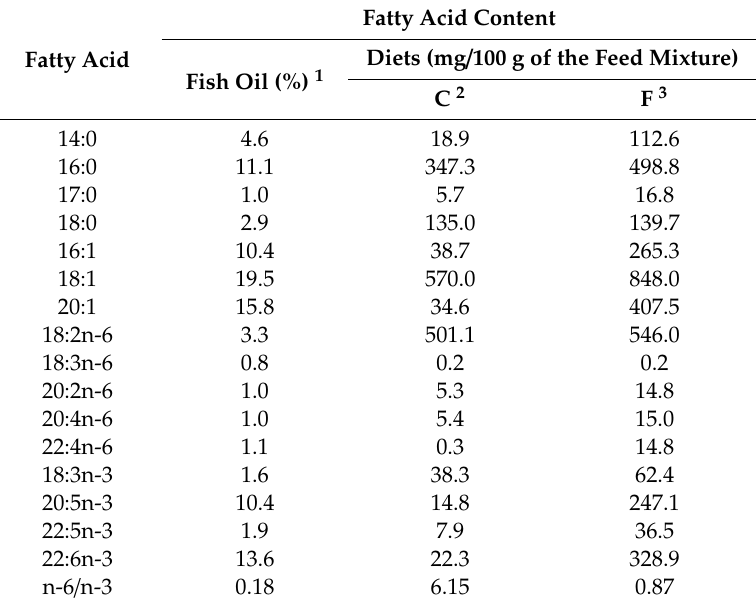
Table 2. Fatty acid content in fish oil and in the diets (sixteen fatty acids identified according to the retention times of the standard are